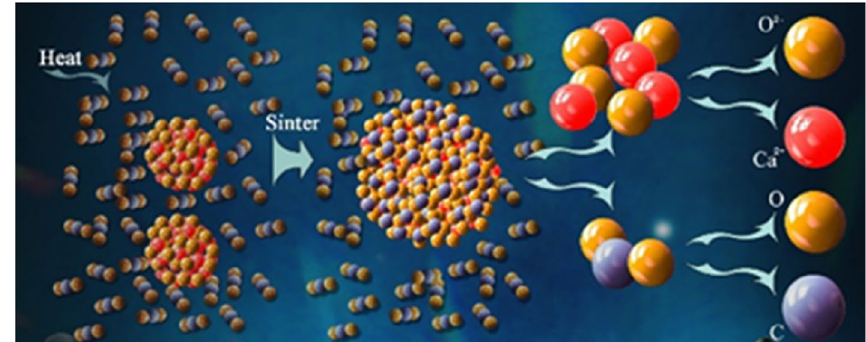
Fig. 10 The sintering mechanism of CaO materials during TCES process